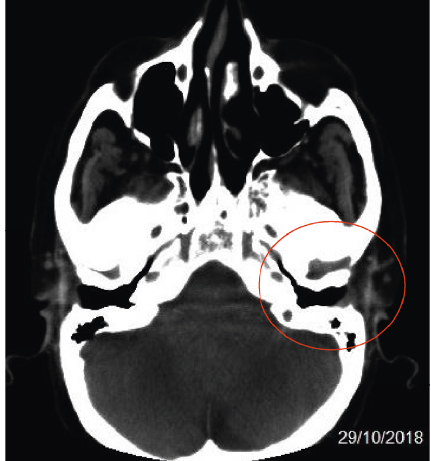
Figure 4: CT scan of the left ear without